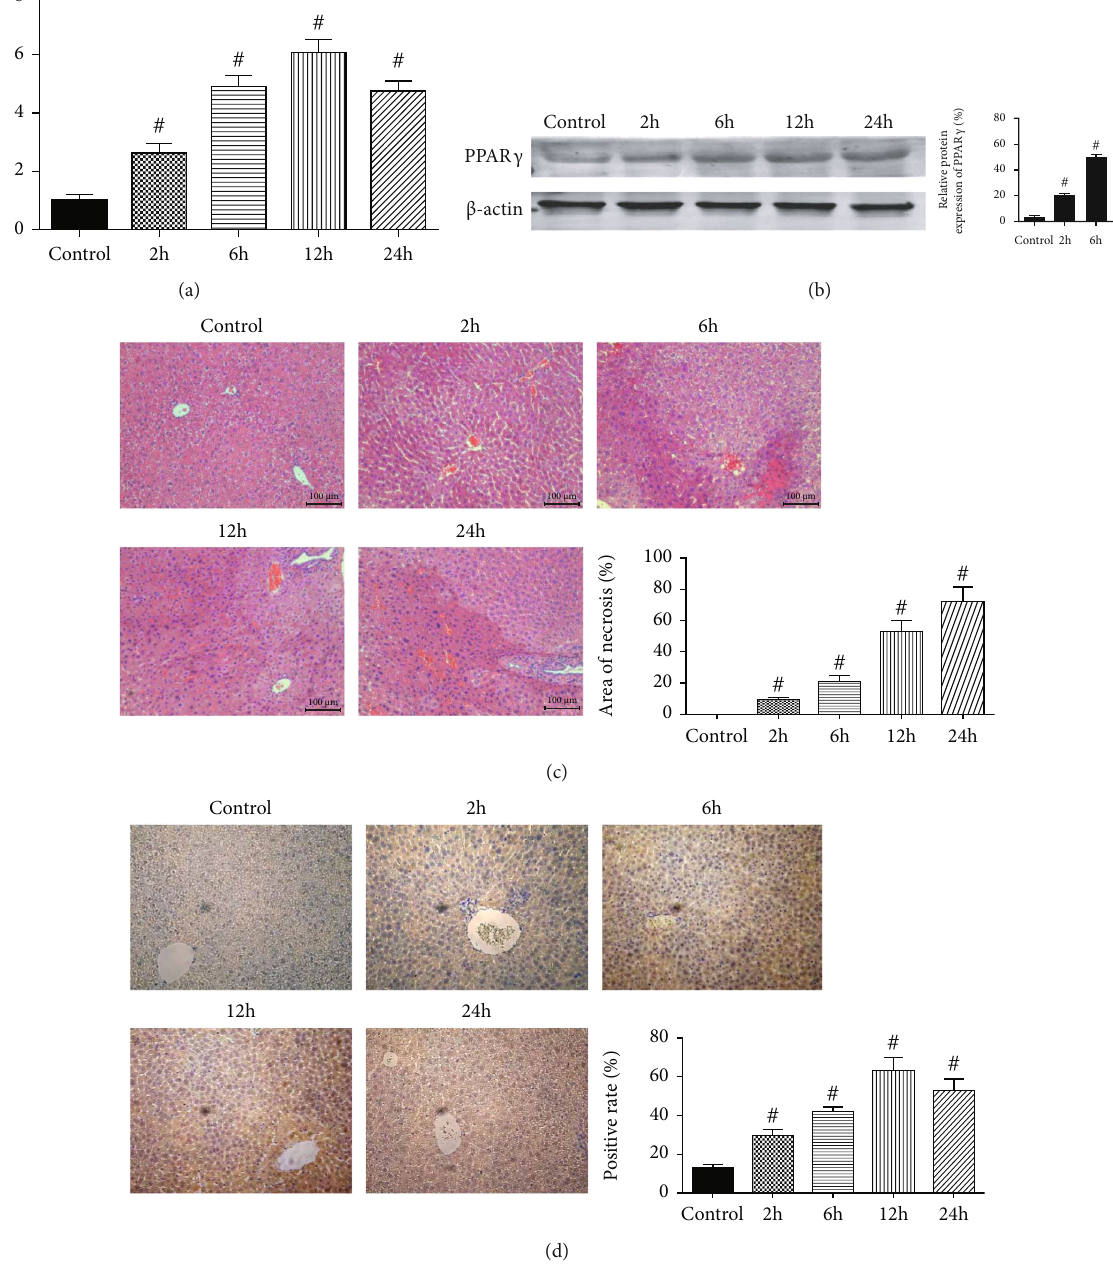
Figure 1: The expression of PPAR γ in IR injury. Notes: (a) relative mRNA expression of PPAR γ ( n = 5 , # means p < 0 : 05 for IR versus control after 2, 6, 12, and 24h); (b) protein expression of PPAR γ ( n = 3 , # means p < 0 : 05 for IR versus control after 2, 6, 12, and 24 h); (c) representative H&E stained sections of the liver (original magni fi cation, × 200). The ratio of necrosis area to total area was analyzed with Image-Pro Plus 6.0 ( n = 5 , # means p < 0 : 05 for IR versus control after 2, 6, 12, and 24h); (d) Immunohistochemistry staining ( × 200) showing the expression of PPAR γ . The ratio of brown area to total area was analyzed with Image-Pro Plus 6.0 ( n = 5 , # means p < 0 : 05 for IR versus control after 2, 6, 12, and